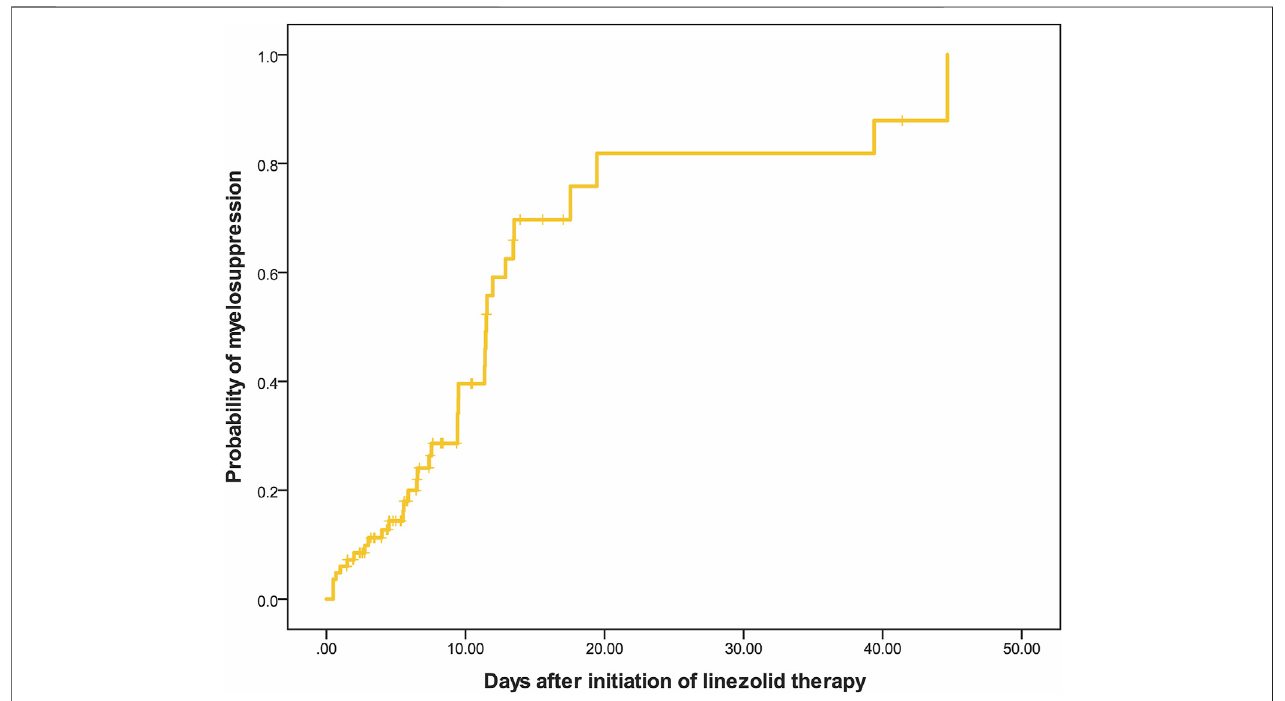
FIGURE 3 | Kaplan – Meier plot showing the time from the initiation of linezolid therapy to the development of myelosuppression (n = 83).